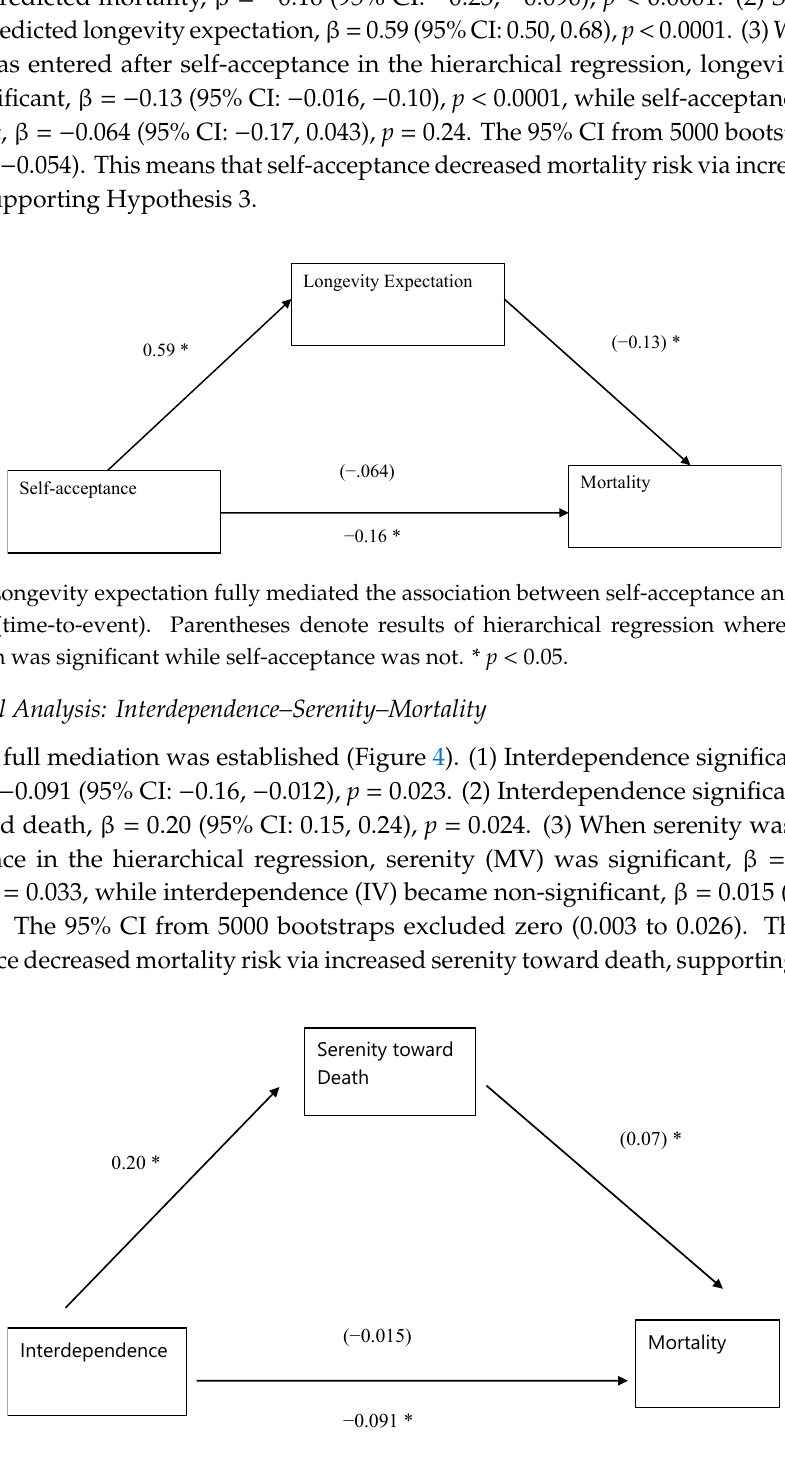
Figure 4. Serenity toward death fully mediated the association between interdependence and all-cause mortality (time-to-event). Parentheses denote results of hierarchical regression where serenity toward death emerged significant while interdependence did not. * p <